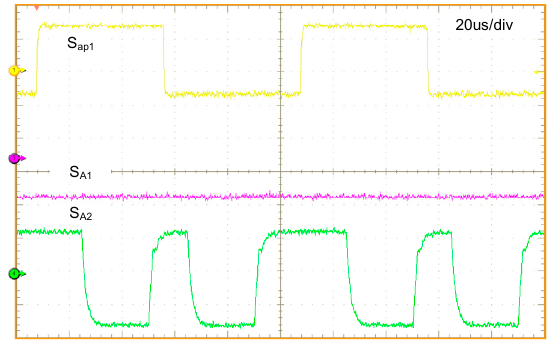
Figure 15. The zoom-in of PWM signals of rectifier and inverter stages.